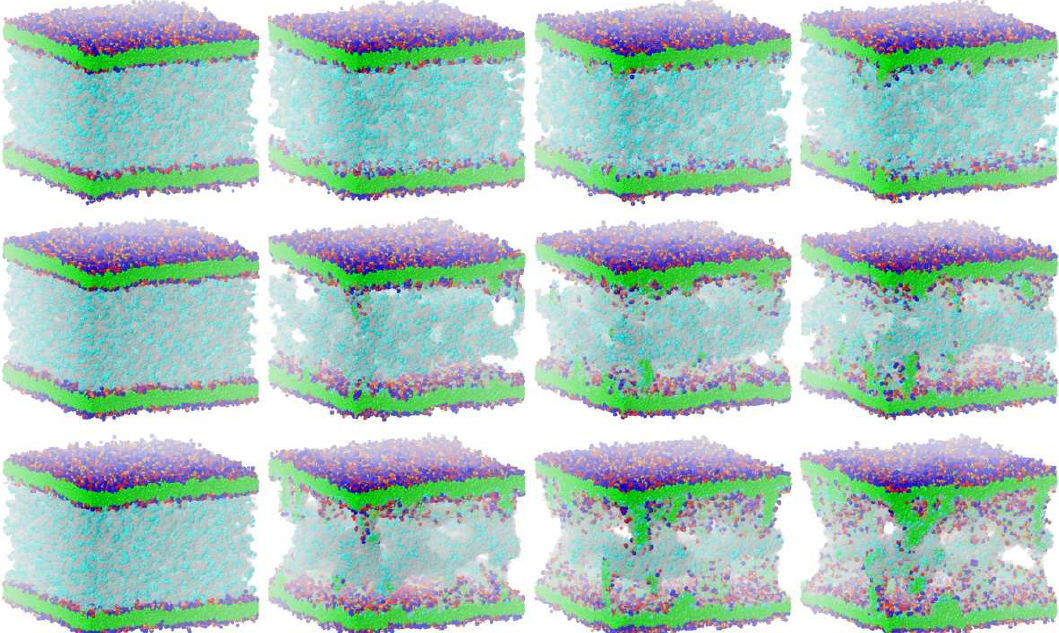
Figure 3. Cyclotide-induced membrane disruption by lipid extraction: Simulation box views of the “sandwich” cyclotide/membrane systems kB1-W19Y-P20S-V21T-L27T-P28S-V29T/NoC-PM (top row), kB1-W19Y-P20S-V21T/NoC-PM (middle row), and kB1/NoC-PM (bottom row) at 500 (first column), 35,000 (second column), 70,000 (third column), and 100,000 (fourth column) integration time steps (corresponding to 6 microseconds). Phospholipid particles in blue and red are charged, uncharged hydrophobic phospholipid particles are colored in green, cyclotide backbone particles are transparently shown in gray, with backbone particles of the cyclotides hydrophobic patch being colored in cyan. All water particles are omitted from the display, and the simulation boxes are truncated accordingly. The simulations show the CDS approach with an electrostatic cut-off radius of 5 reduced DPD length units.